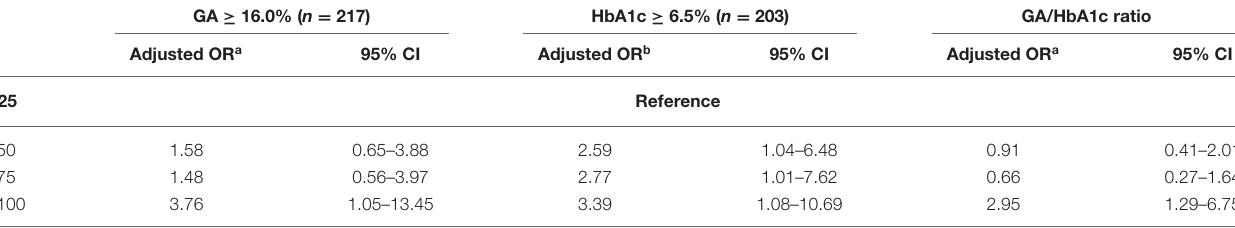
TABLE 3 | Multinomial logistic regression analysis: impact of higher GA ( ≥ 16.0%) on each quartile of infarct volume (reference =